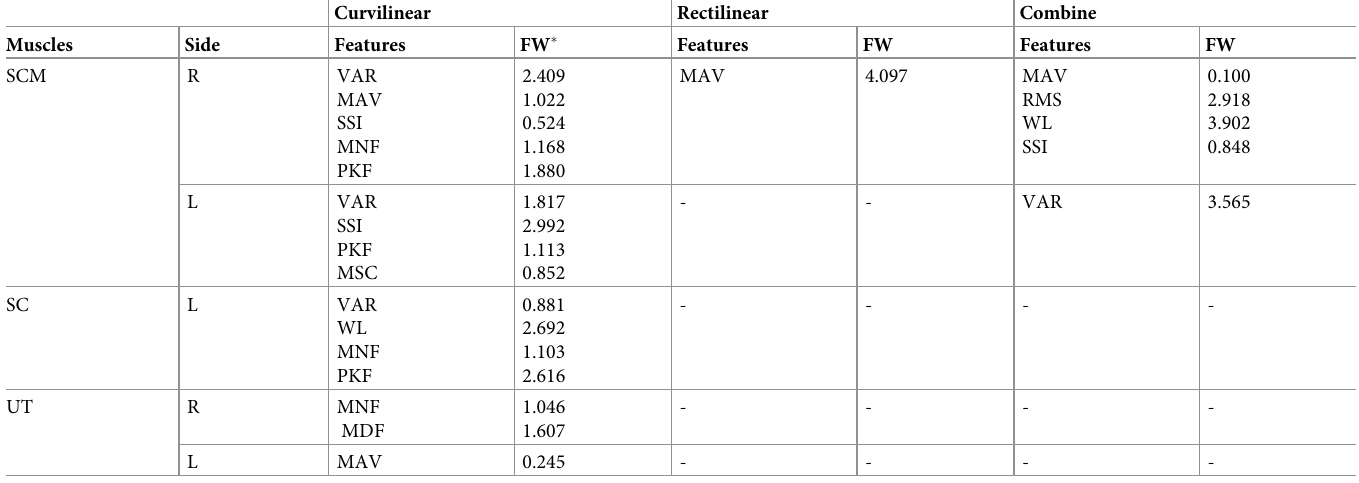
In contrast, features measured during rectilinear gait or combined trajectories lead to poor classification, obtaining a maximum accuracy of 55% and 62.50%, respectively using the SVM algorithm. Considering the performance of NCA-SVM, we also analyzed the classification power of each muscle individually through this model (see Fig 5). The best classification performance corresponds to the SC muscle during curvilinear gait with an accuracy of 70%, a specificity of 78% and a sensitivity of 60%, followed by SCM with an accuracy of 65%, a specificity of Table 4. Selected features by